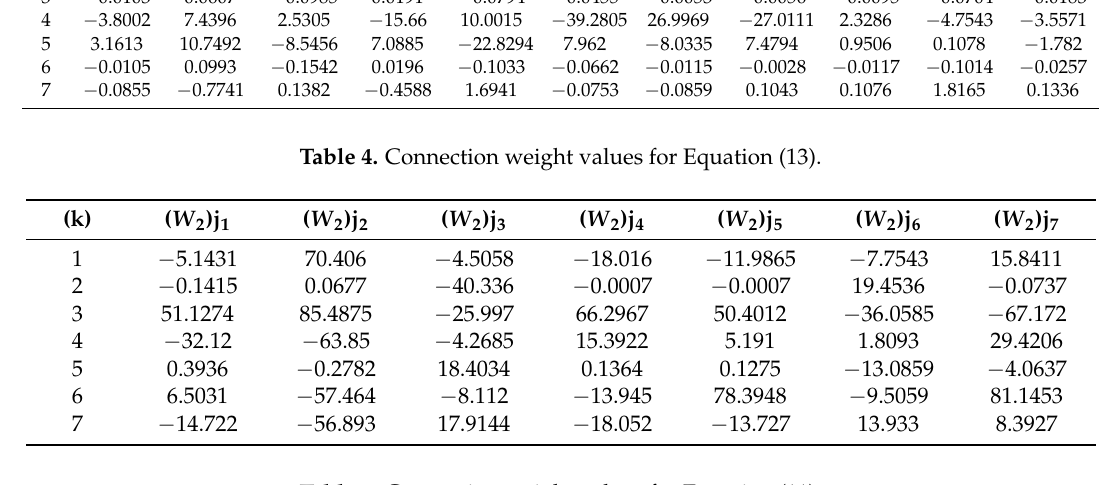
Table 5. Connection weight values for Equation (11).